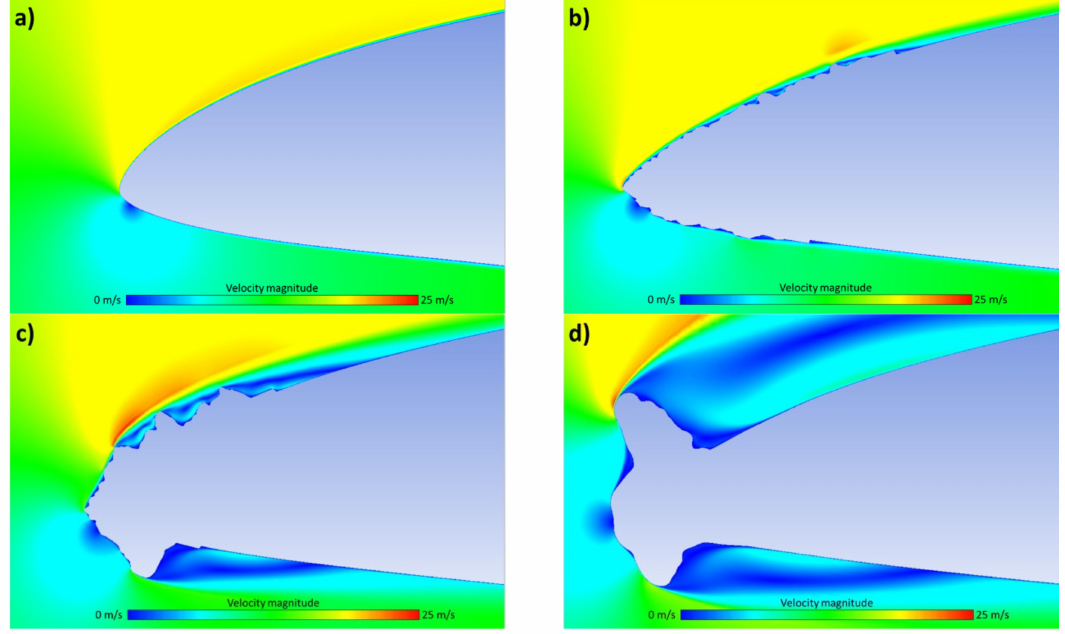
Figure 13. FENSAP results for the velocity field of the clean ( a ), rime ( b ), glaze ( c ), and horn* ( d )